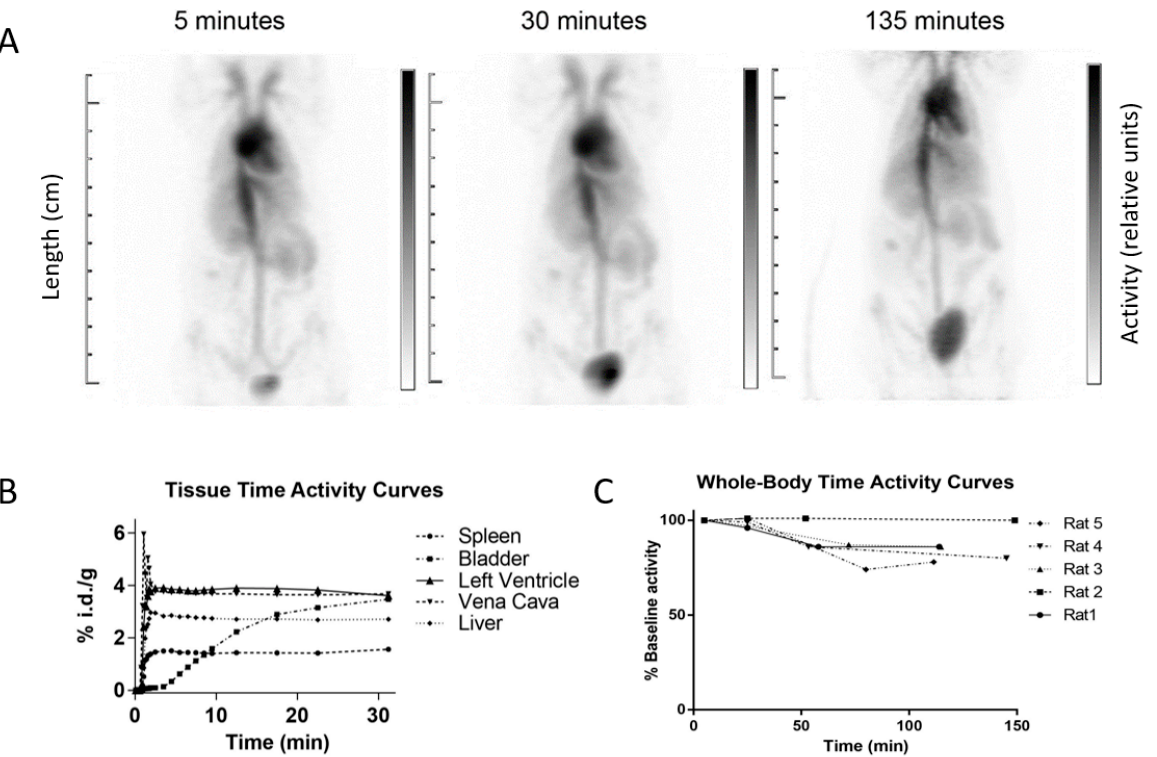
Figure 2. ( A ) 68 Ga-NOTA-HPG biodistribution measured over time by PET imaging shows the typical blood pool imaging pattern. ( B ) Mean ± SD time–activity curves of 68 Ga-HPG from the dynamic acquisition in different tissues. ( C ) The whole-body time–activity curves of all animals are shown over 2.5 h ( n = 5).